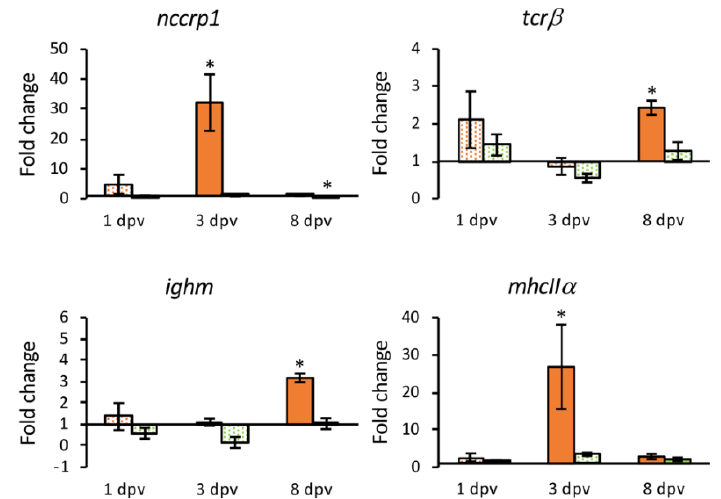
Figure 10. Relative expression levels (2 −ΔΔ Ct ) of genes coding cell receptor markers in the intestine from vaccinated (orange) and mock-vaccinated (green) fish at different times post-vaccination (dpv). Differentially expressed genes (DGEs) are represented in solid color. Data are expressed as mean ± SEM (n = 5). Significant differences are indicated by an asterisk ( p < 0.05).